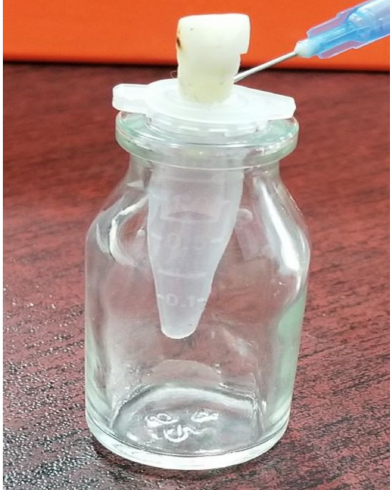
Figure 1. The experimental model used to collect extruded